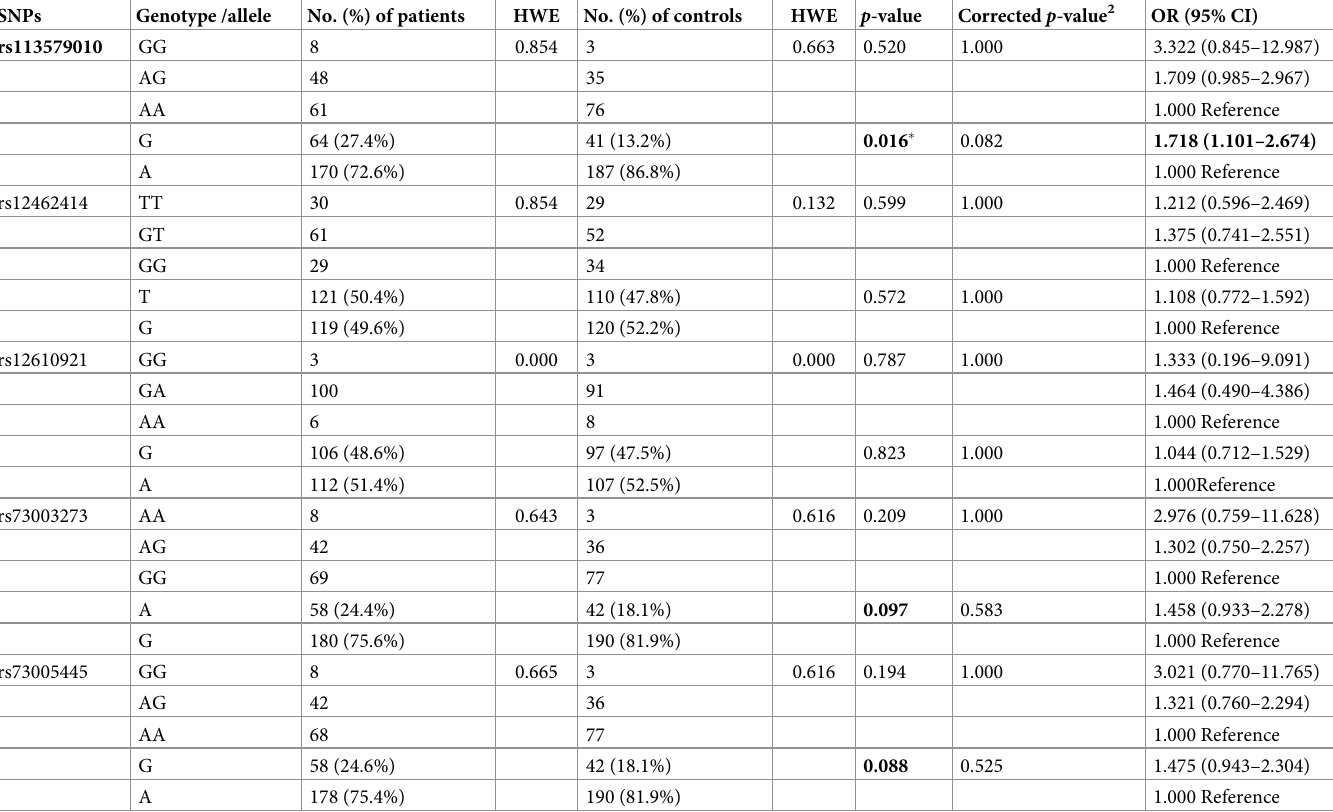
Table 1. Genotypic and allelic distributions of five functional SNPs in UCA1 between Taiwanese endometriosis patients and controls 1 . SNPs Genotype